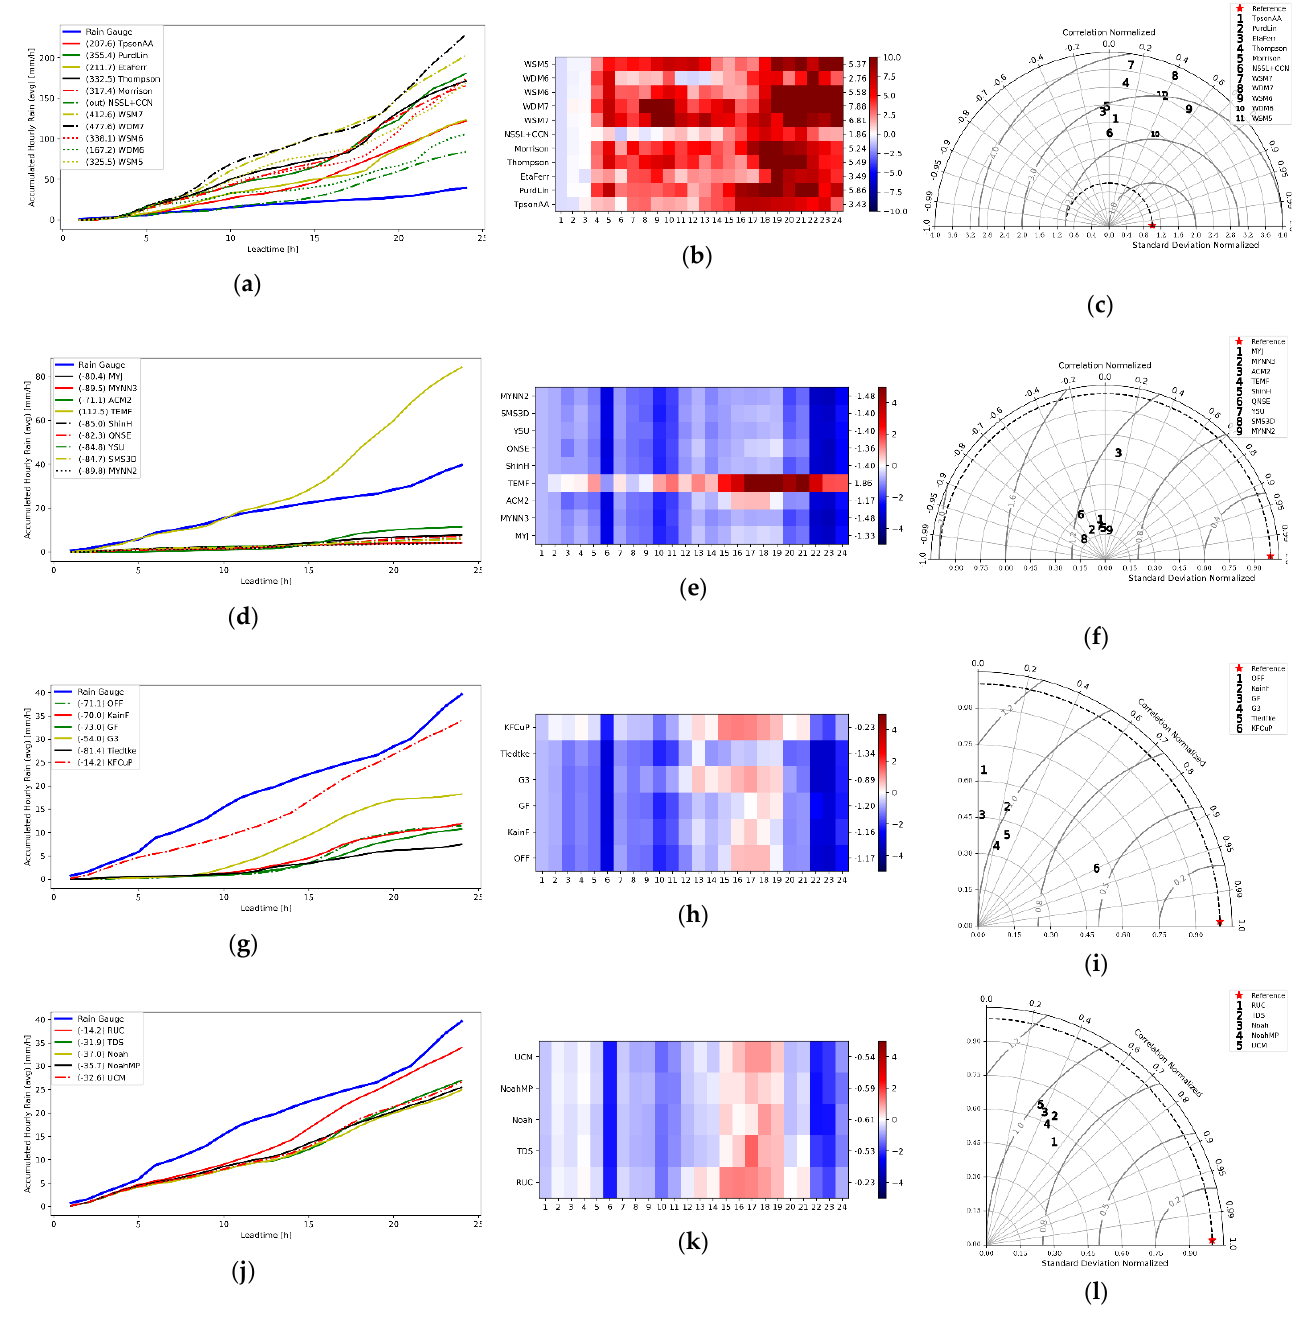
Figure 6. As in Figure 4 but for event 3.